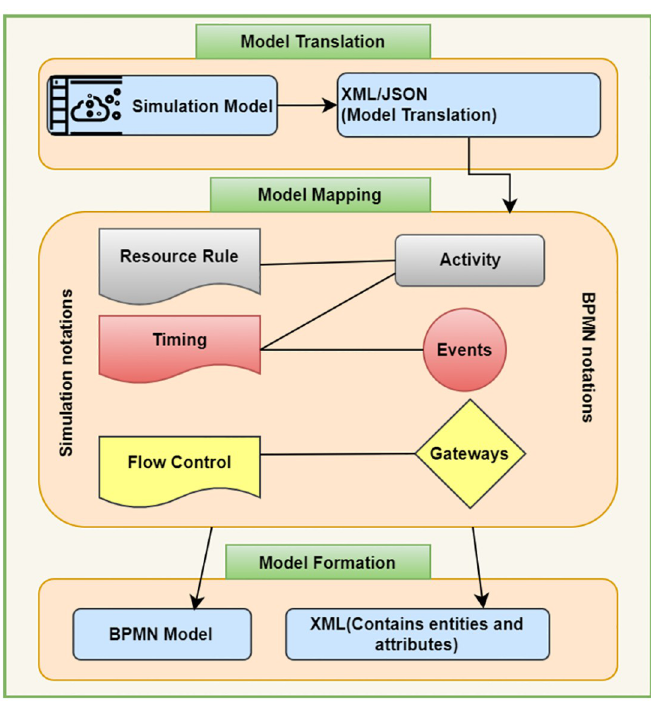
Fig 2. Generic framework showing three layers, model translation, model mapping and model formation.